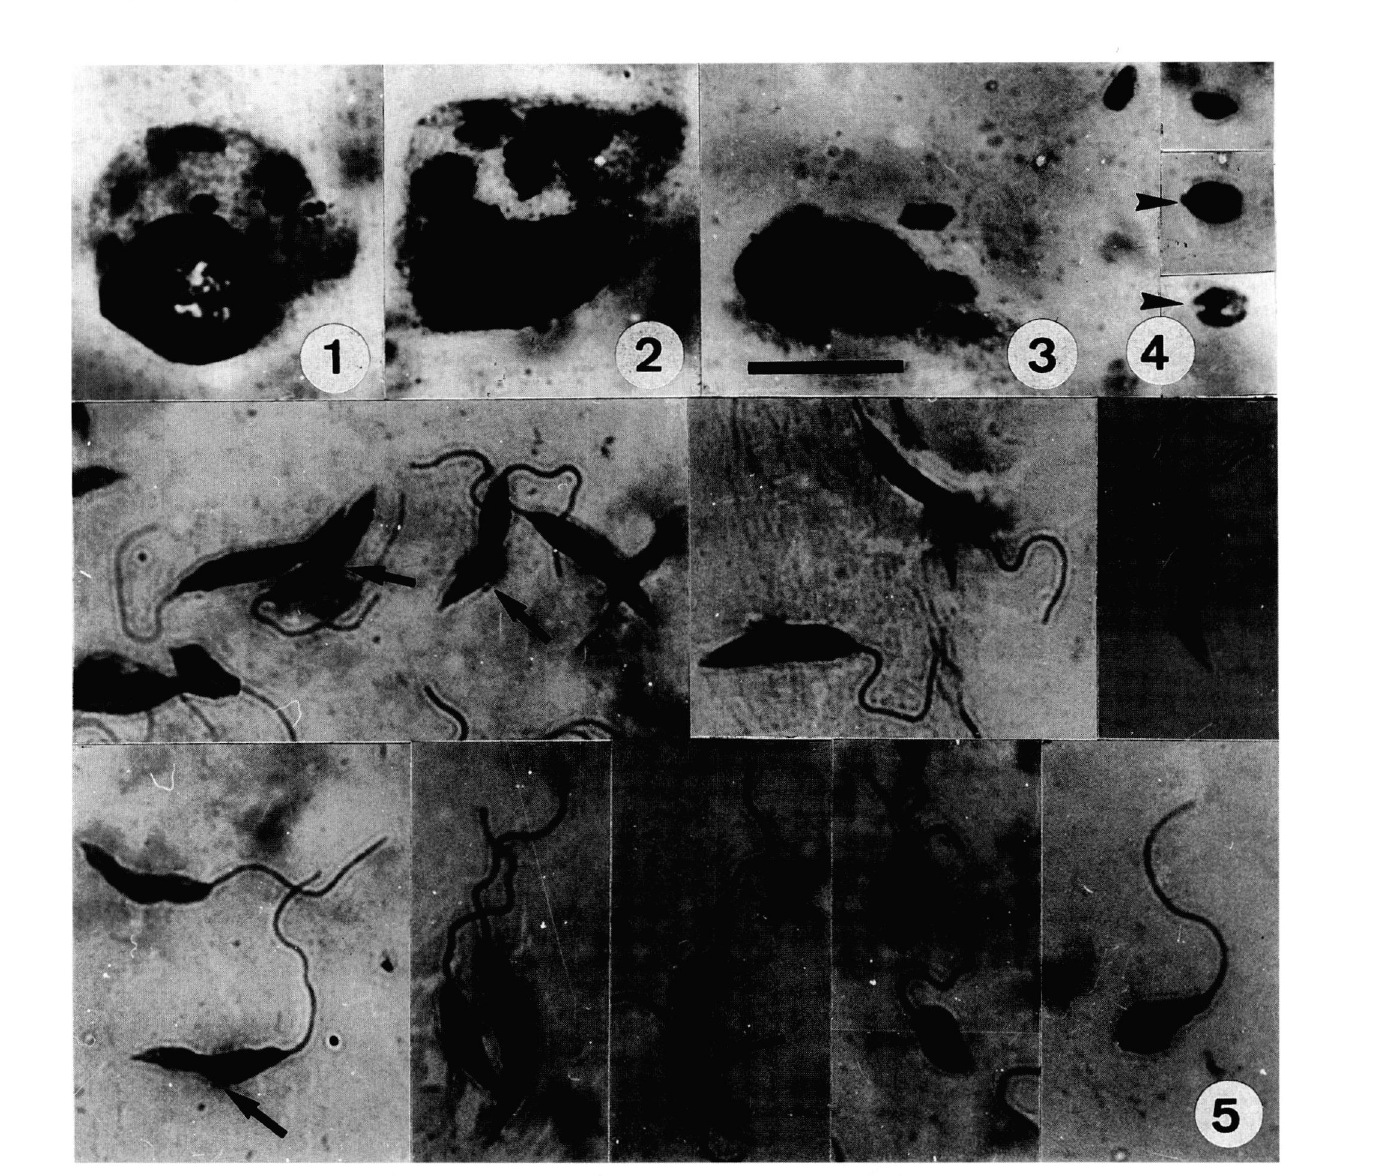
Figs 1-5 - Leishmania (Viannia) lindenbergi n. sp. Figs 1-4: Intracellular and extracellular amastigotes in a Giemsa-stained smear of exu­ date from the cutaneous lesion of a patient. Some parasites are in division (arrow-heads). Fig. 5: Giemsa-stained promastigotes from a 7 day-old culture, showing a variety of short, stumpy and elongated forms and a dividing parasite (arrow-head). Elongated promastigotes are frequently twisted upon themselves (arrowed). Bar = 10 u.